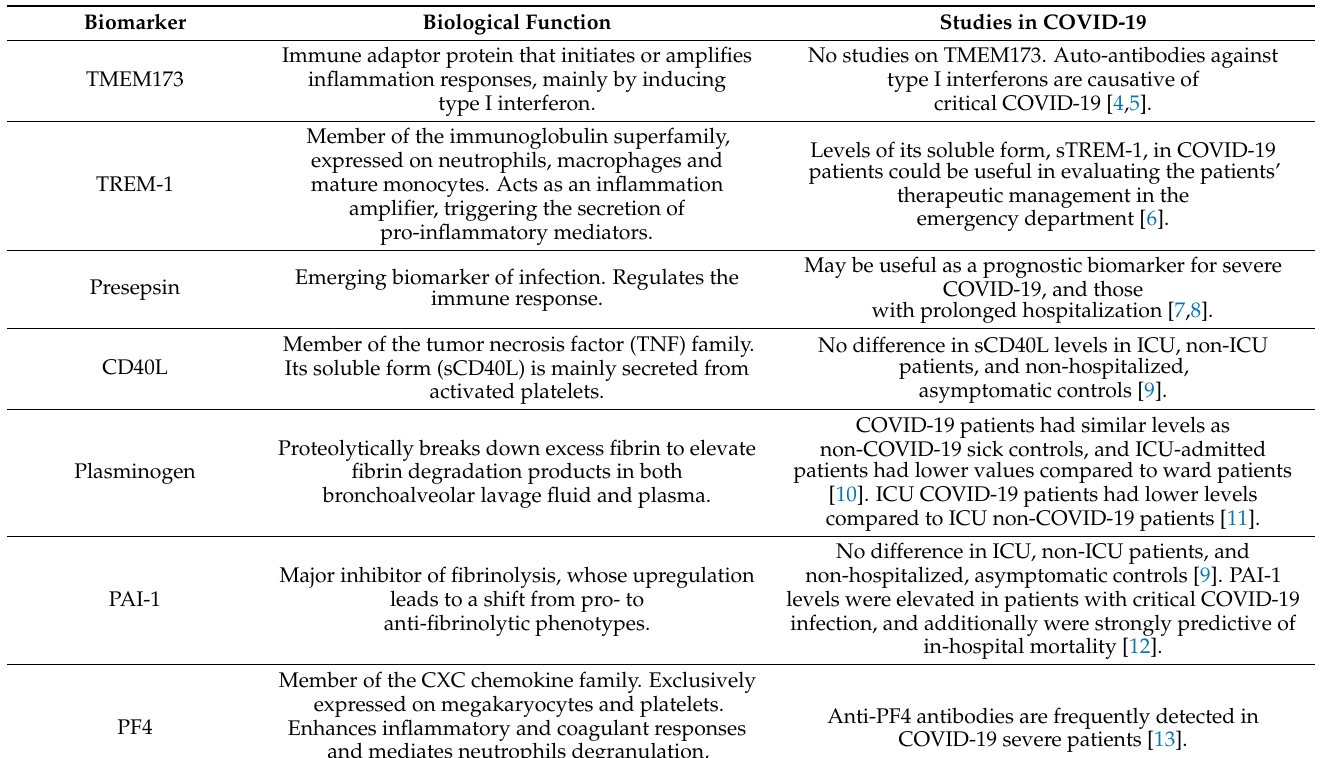
Table 4. Characteristics of the biomarkers measured in the study